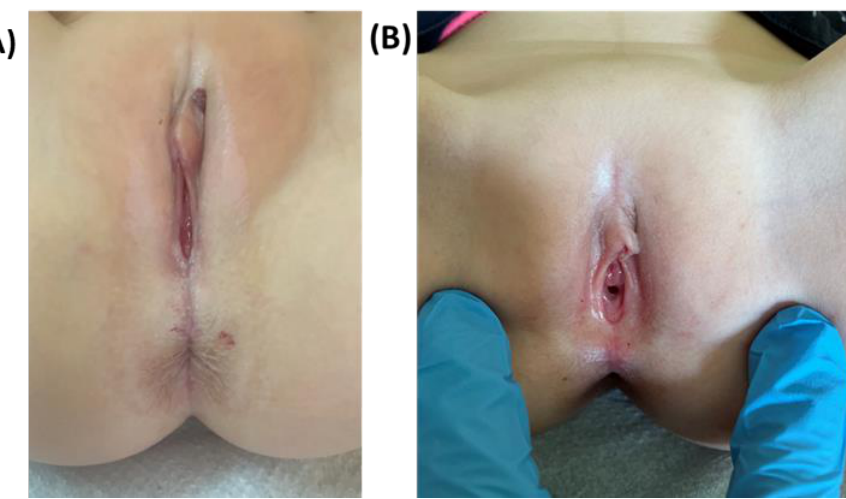
Figure 6. Sample image of premenarchal lichen. ( A ) Typical presentation of pediatric lichen scle- rosus in a 5-year old girl; ( B ) the same case after 8 weeks of treatment with 0.05% clobetasol propi-